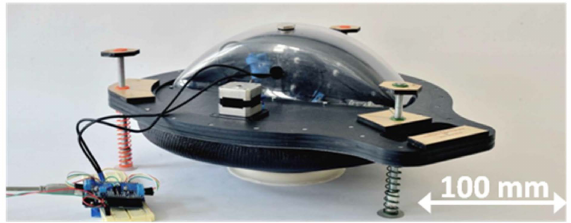
Figure 16. Current design of portable UPS